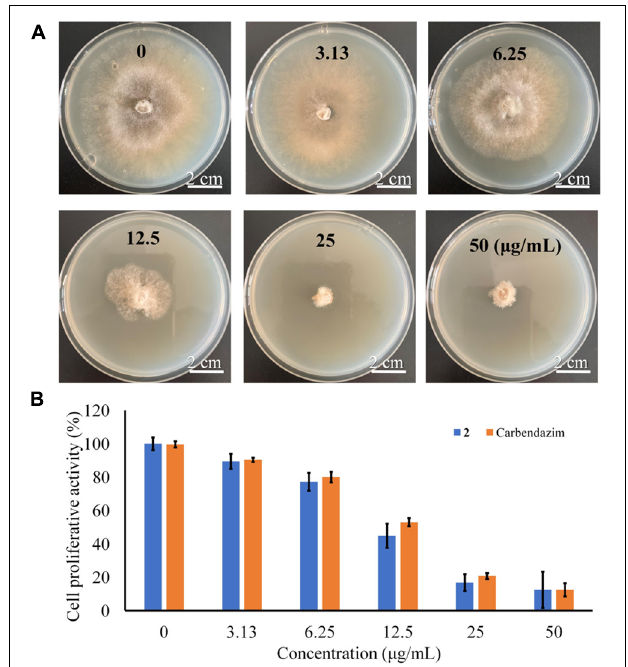
FIGURE 7 | (A) Antifungal assay against B. cinerea with different concentrations. (B) Inhibition of proliferative activity against B. cinerea induced by